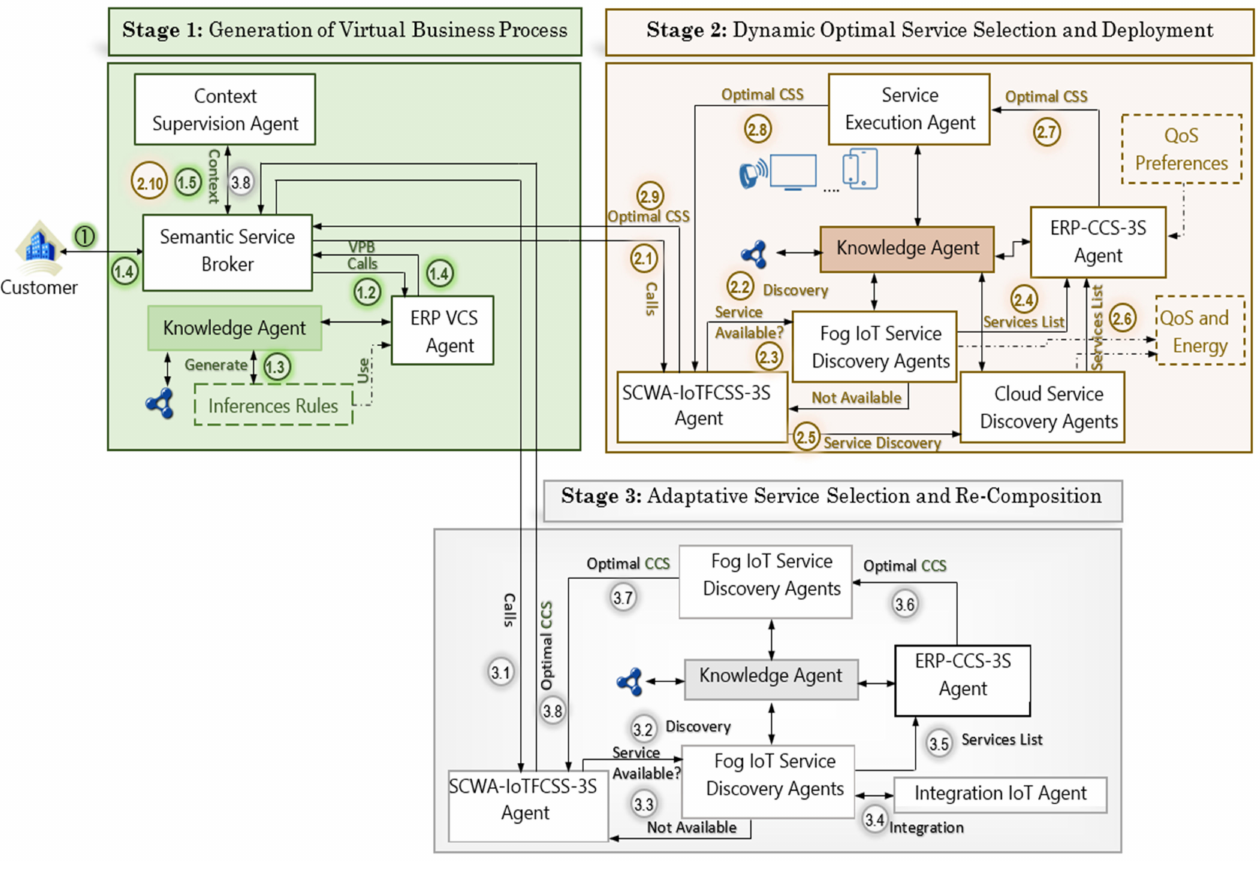
Figure 10. SCwA-IFCCS-3S functional